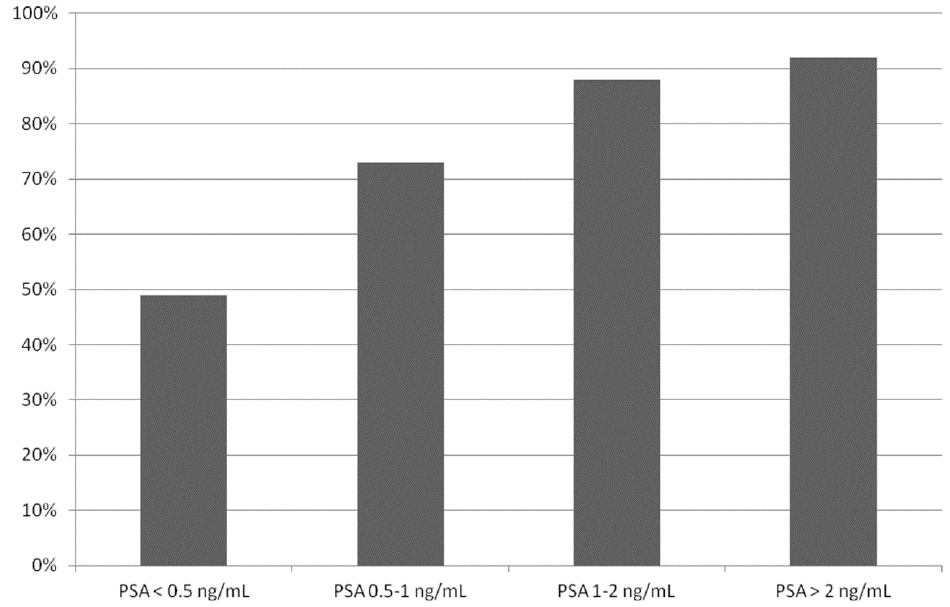
Figure 4. Bar graph showing the pooled detection rate of 18 F-PSMA PET / CT in biochemical recurrent prostate cancer on a per patient-based analysis, according to different PSA serum values.